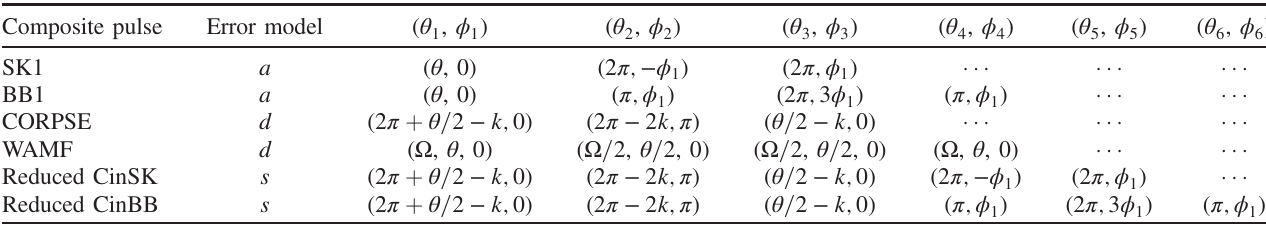
TABLE III. Single-qubit DES-protected gates enacting net operation R ð θ ; 0 Þ , following Ref. [59]. Here, ϕ 1 ¼ cos − 1 ð − θ = 4 π Þ , k ¼ arcsin ½ sin ð θ = 2 Þ = 2 (cid:5) , a is amplitude noise, d is detuning noise, and s is for simultaneous amplitude and detuning noise. Unless otherwise noted, the Rabi frequency Ω remains fixed during all segments. The Walsh-modulated DCG sequence (WAMF) [49,61,62] maintains constant segment durations τ and employs amplitude modulation of the Rabi rate as described below. l Composite